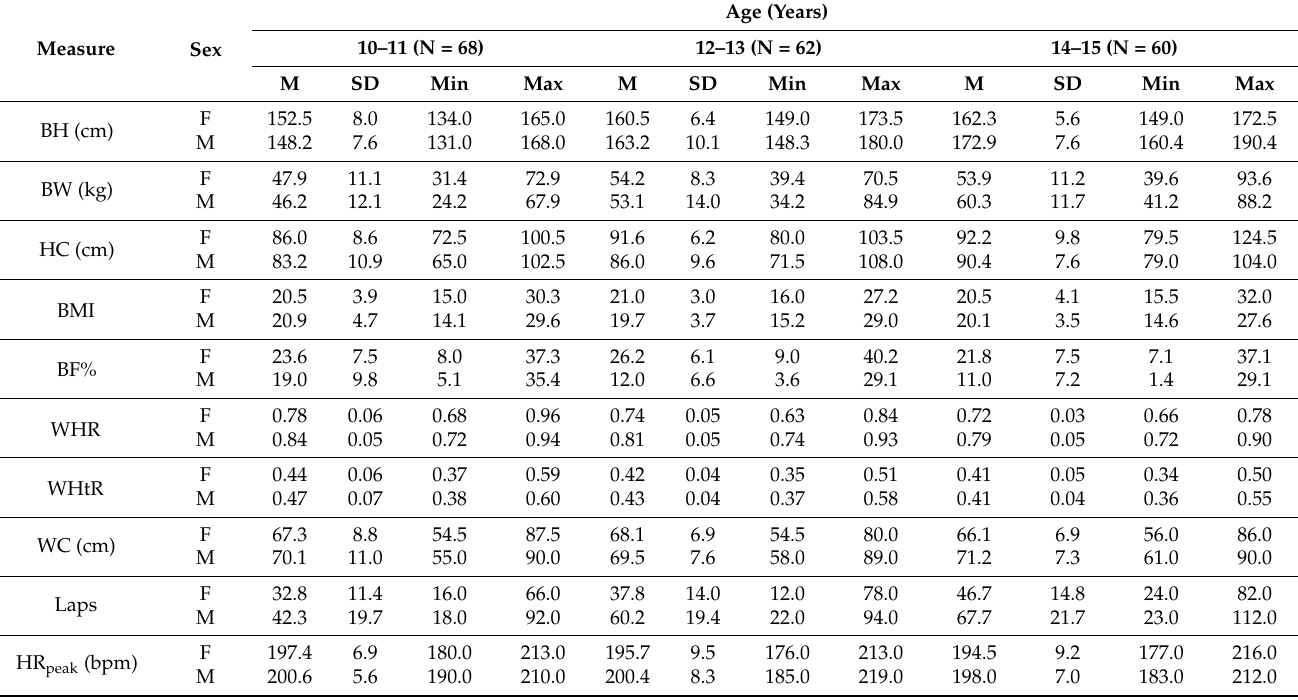
Table 1. Test group